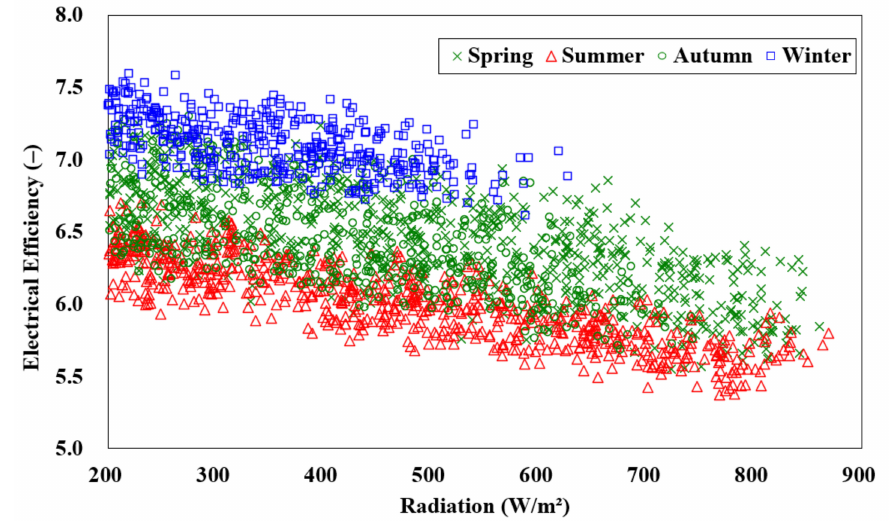
Figure 11. Annual electrical efficiency variation with solar radiation.